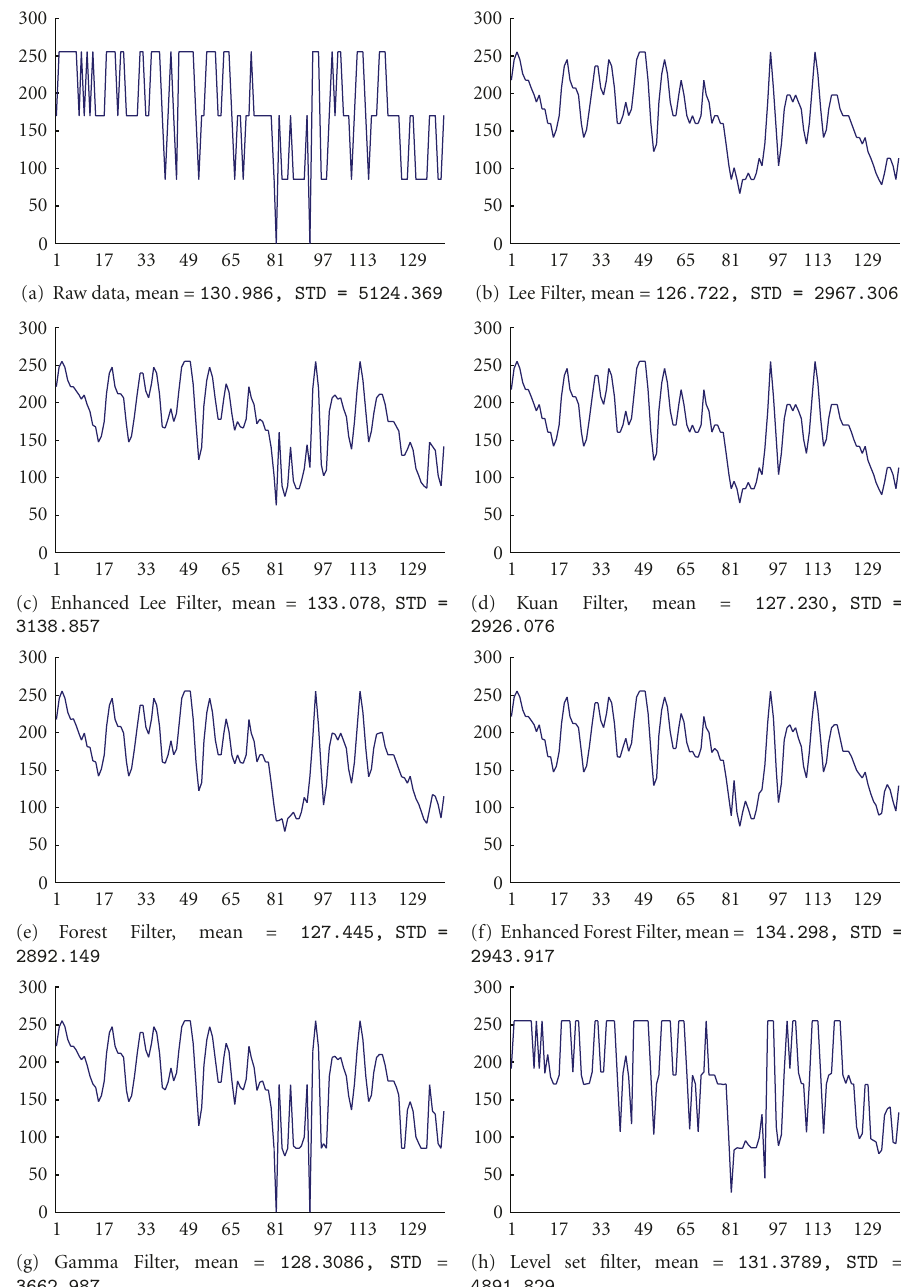
Figure 5: The profiles of Region D resulted from the proposed level set-based filter and conventional approaches.